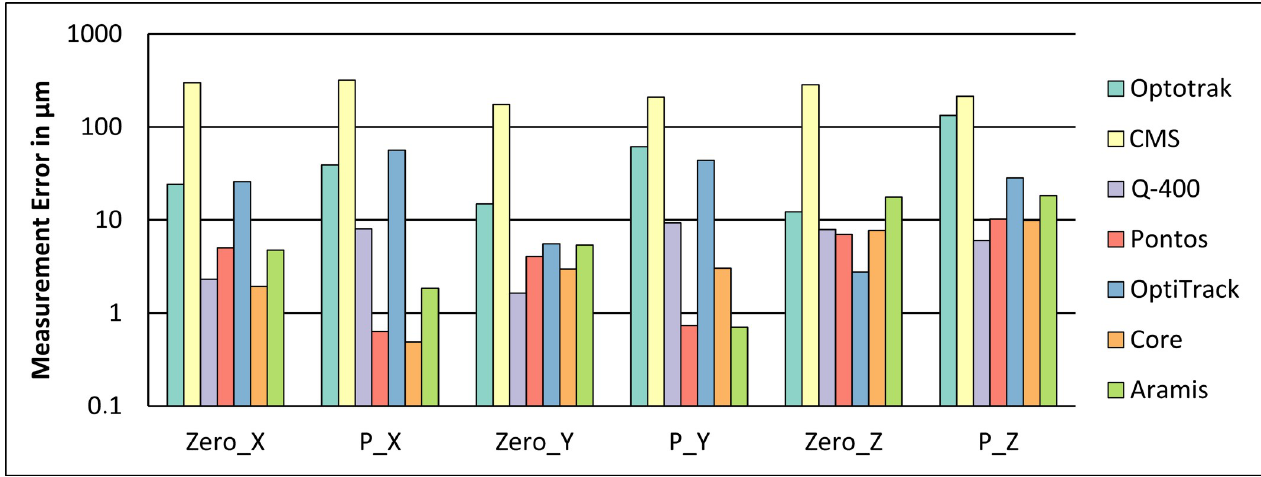
Fig 4. Measurement errors for the zero offset condition in x-, y- and z-direction of the investigated measurement systems.